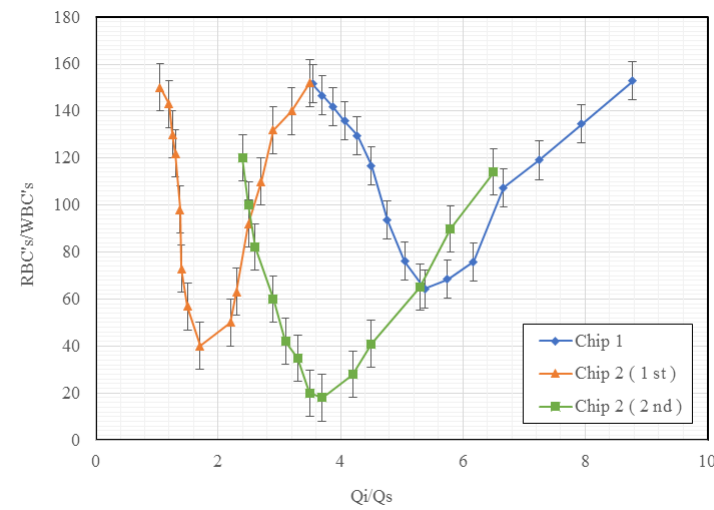
Figure 7. Separation efficiencies to the ratio of injection (Qi) and suction (Qs) flow rates for Chip 1 and Chip 2. (Note: Chip 1 has no obstacle in the curve channels; Chip 2 has obstacles in the curve channels). (Note: Chip 2 (1st and 2nd) has two optimum, as the conditions of the blood samples vary between the 1st and 2nd tests.).